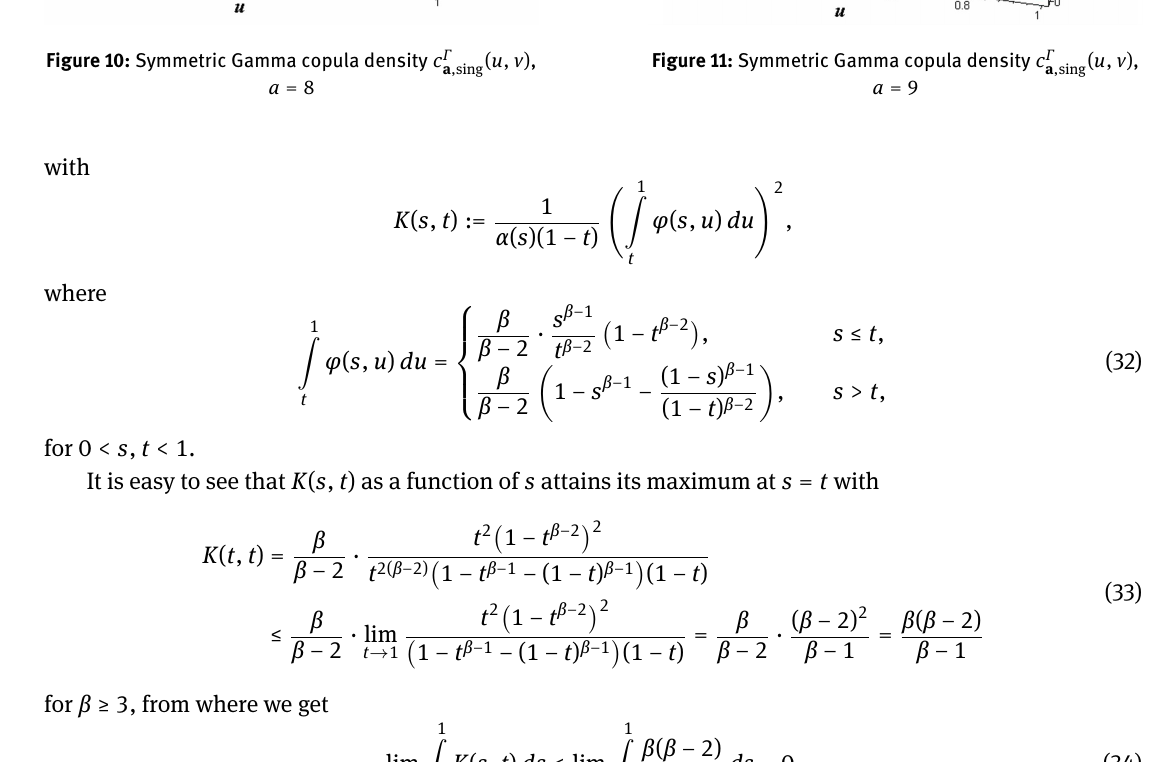
Figure 11: Symmetric Gamma copula density c Γ